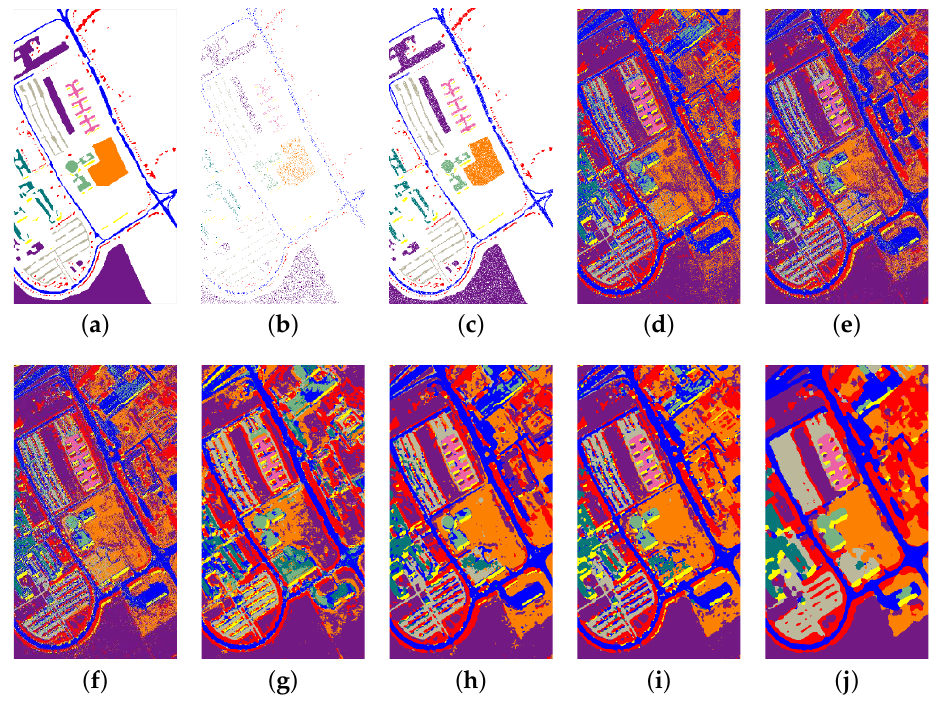
Figure 8. Classification maps for the University of Pavia data set. ( a ) Ground-truth; ( b ) training set; and ( c ) testing set. Classification maps by: ( d ) SVM (87.14%); ( e ) RF (88.15%); ( f ) MLP (90.71%); ( g ) 2D-CNN (92.65%); ( h ) 3D-CNN (97.01%); ( i ) SSRN (99.27%); and ( j ) SSSERN